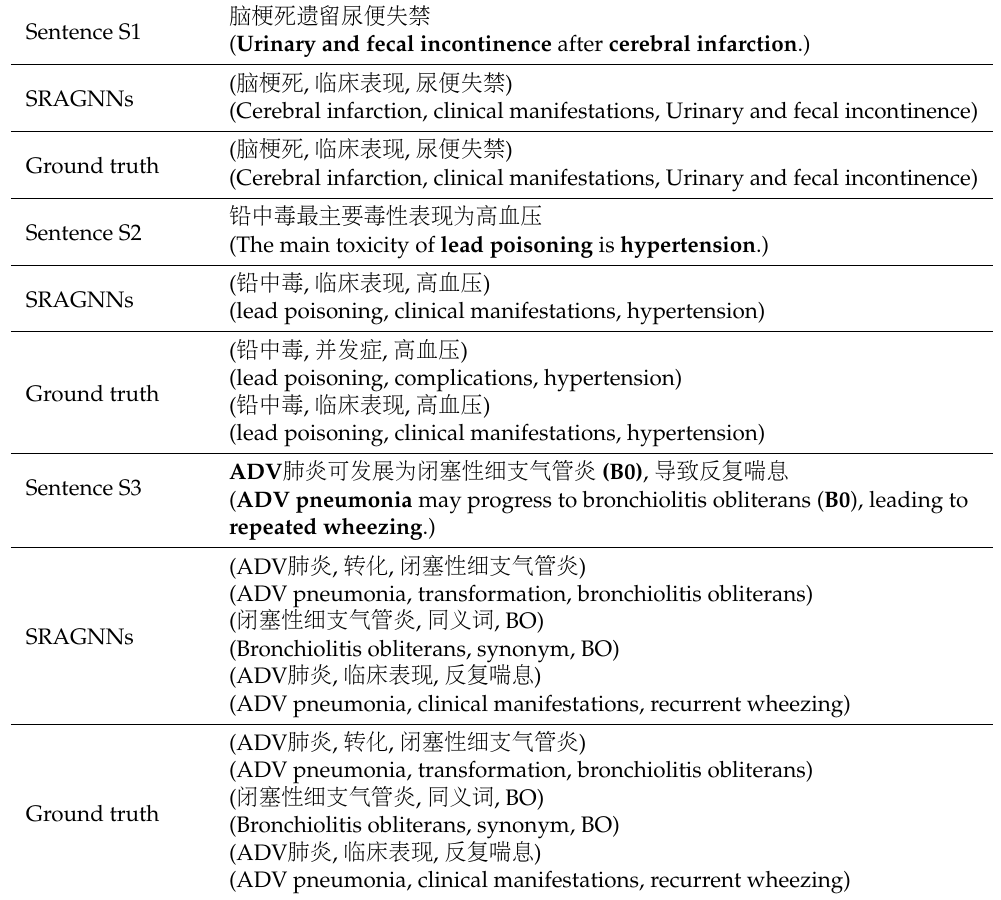
Table 8. Case study of SRAGNNs model on CEMR